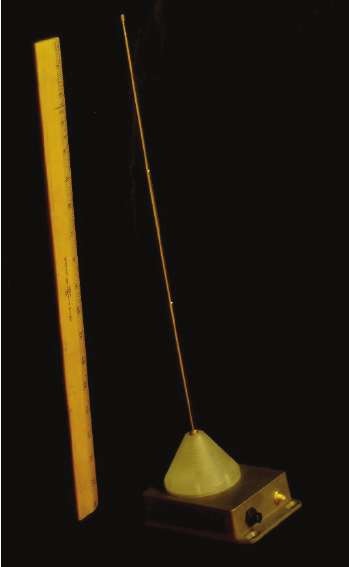
Figure 4: Active antenna assembly with 18 (cid:4)(cid:4) ruler for size compari- son.